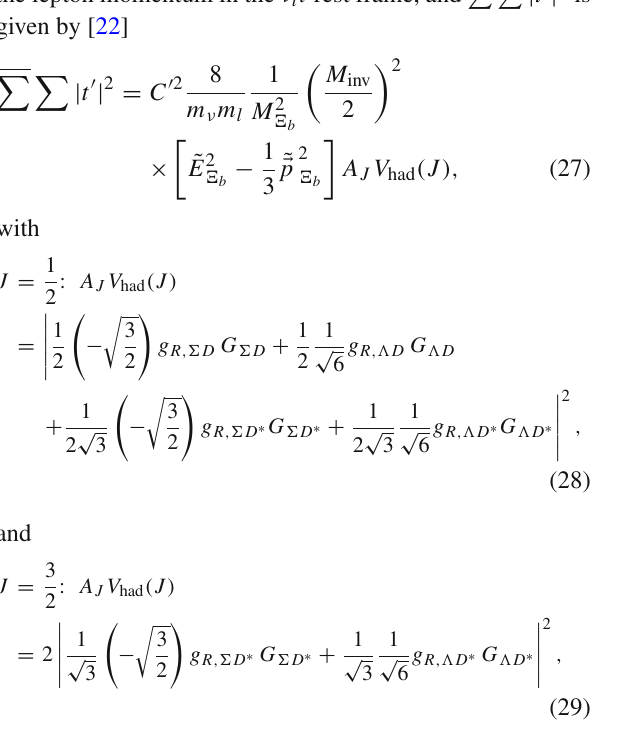
˜(cid:10) ˜ p (cid:2) E (cid:2) and in Eq. (26) are the energies b b